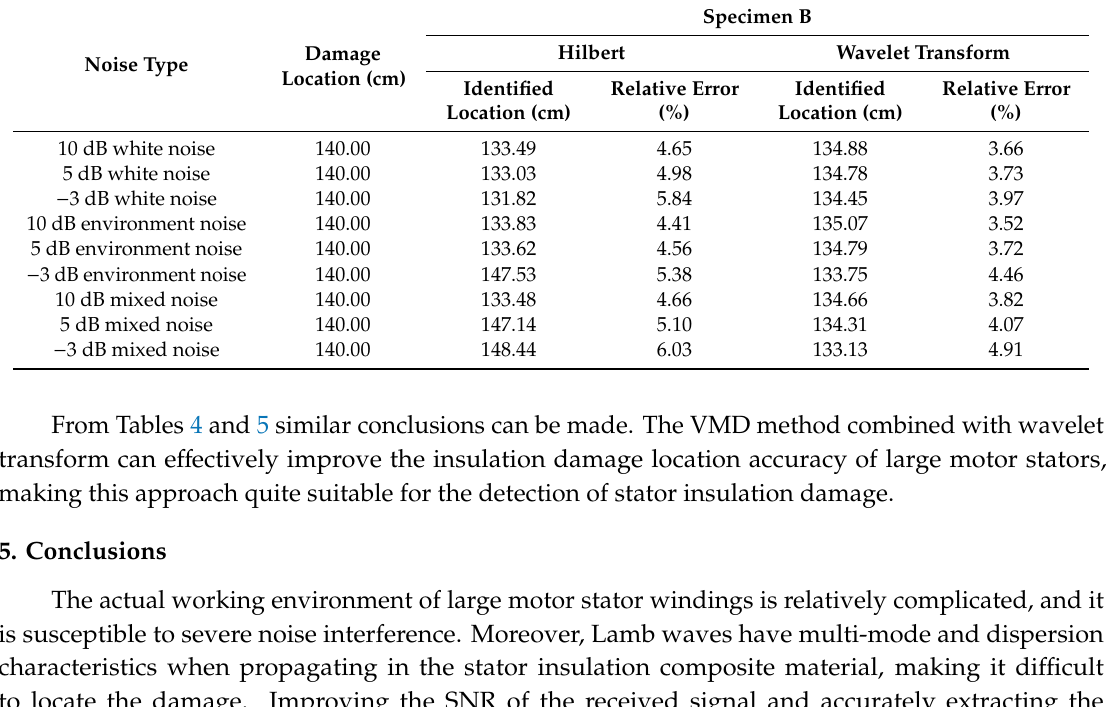
Table 5. Statistics of damage location results of specimen B under di ff erent feature extraction